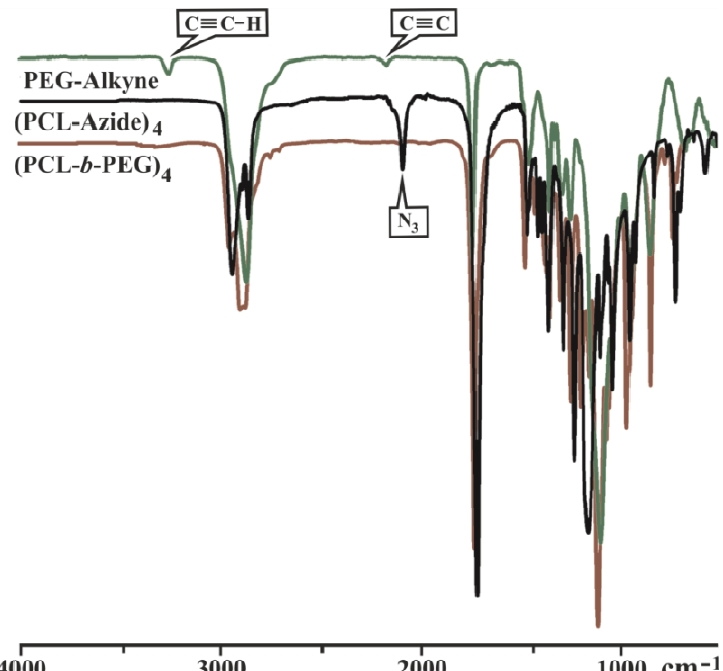
Figure 5. FT-IR spectra of PEG-alkyne, (PCL-azide)